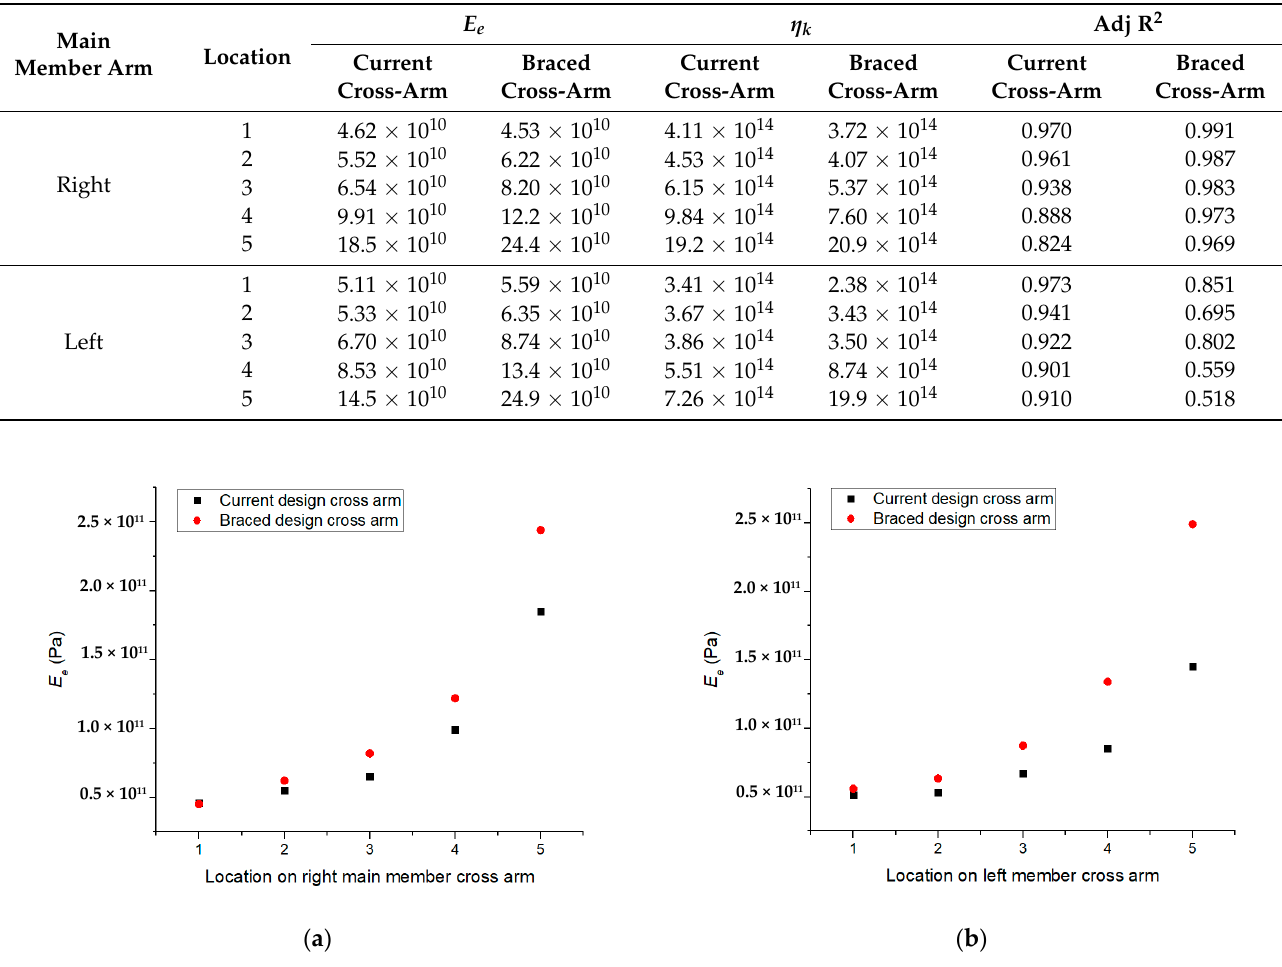
( b ) Figure 12. η k parameter for current and braced wooden cross-arms: ( a ) right; ( b ) left main members. 0.2 × 10 15 0.4 × 10 15 0.6 × 10 15 0.8 × 10 15